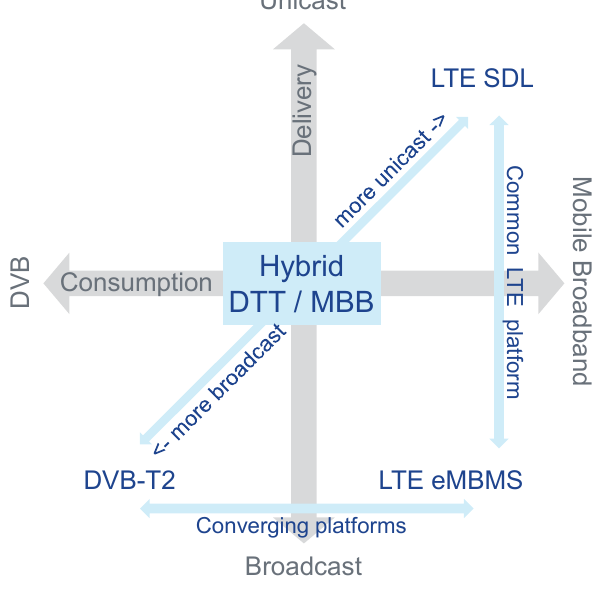
Figure 3. Technology scenarios for the UHF